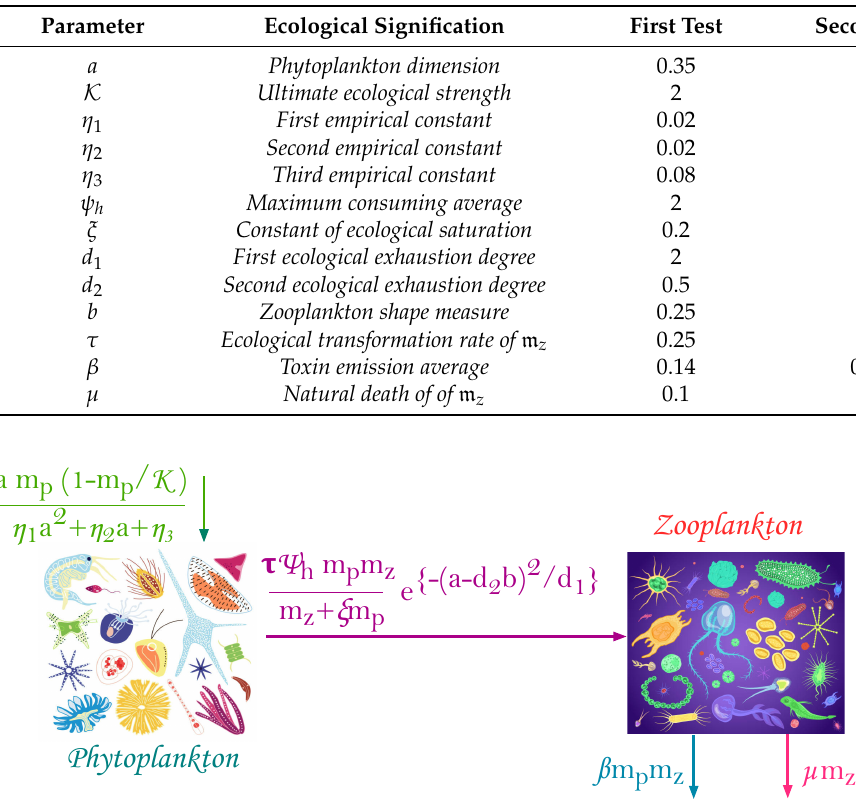
Table 1. Definition of the positive parameters appearing in the phytoplankton-zooplankton model (1).